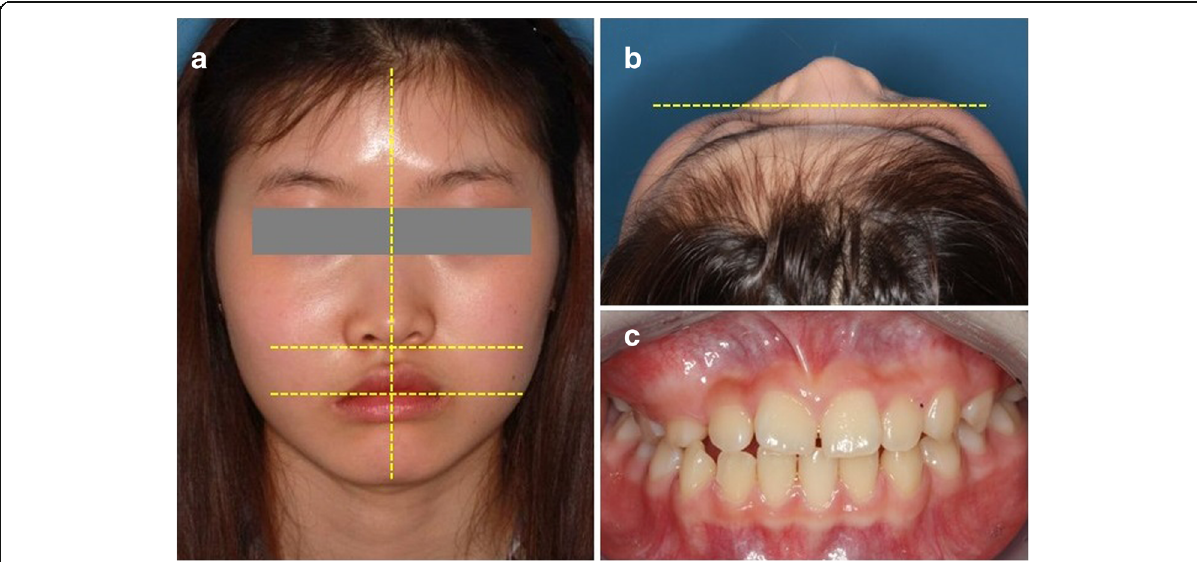
Fig. 1 Preoperative view of enlargement of the right midface. a , b Preoperative photographs showed the enlargement of right face. The ala base and mouth corner on the right side were depressed by the fibrous dysplasia lesion. c Intraoral photograph showed gingival swelling on the right posterior